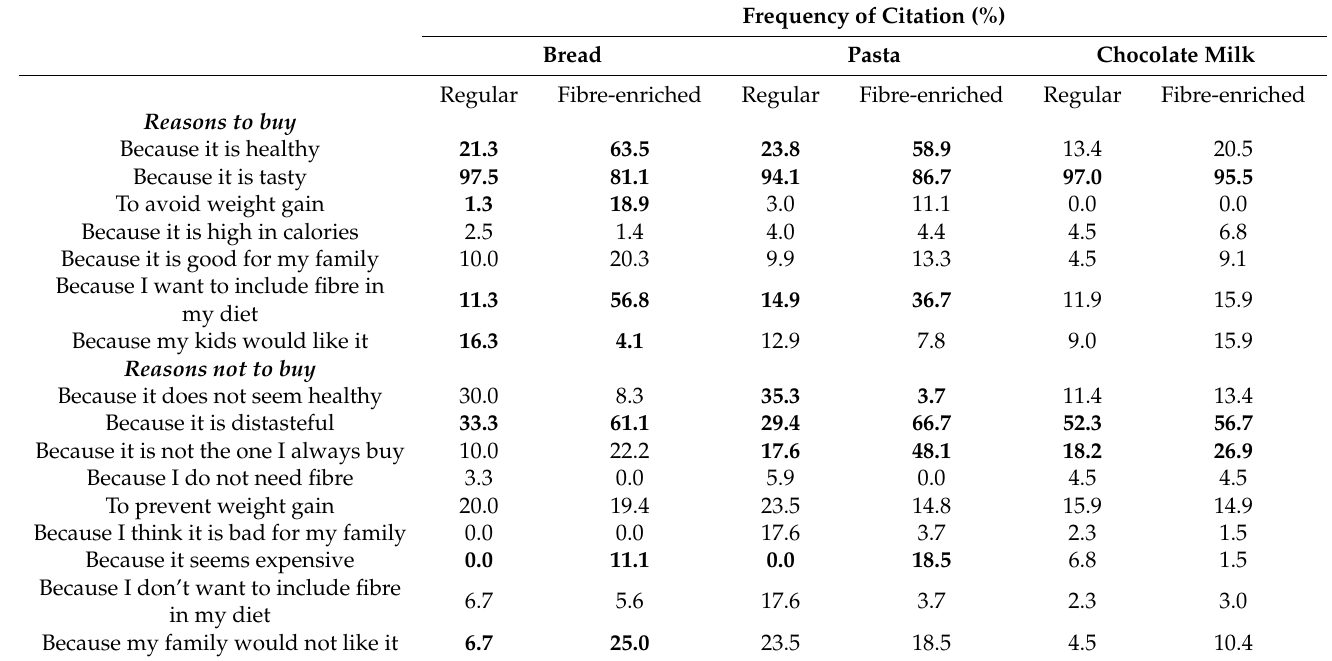
Table 6. Reasons for buying and not buying the regular and fibre-enriched samples of bread, pasta and chocolate